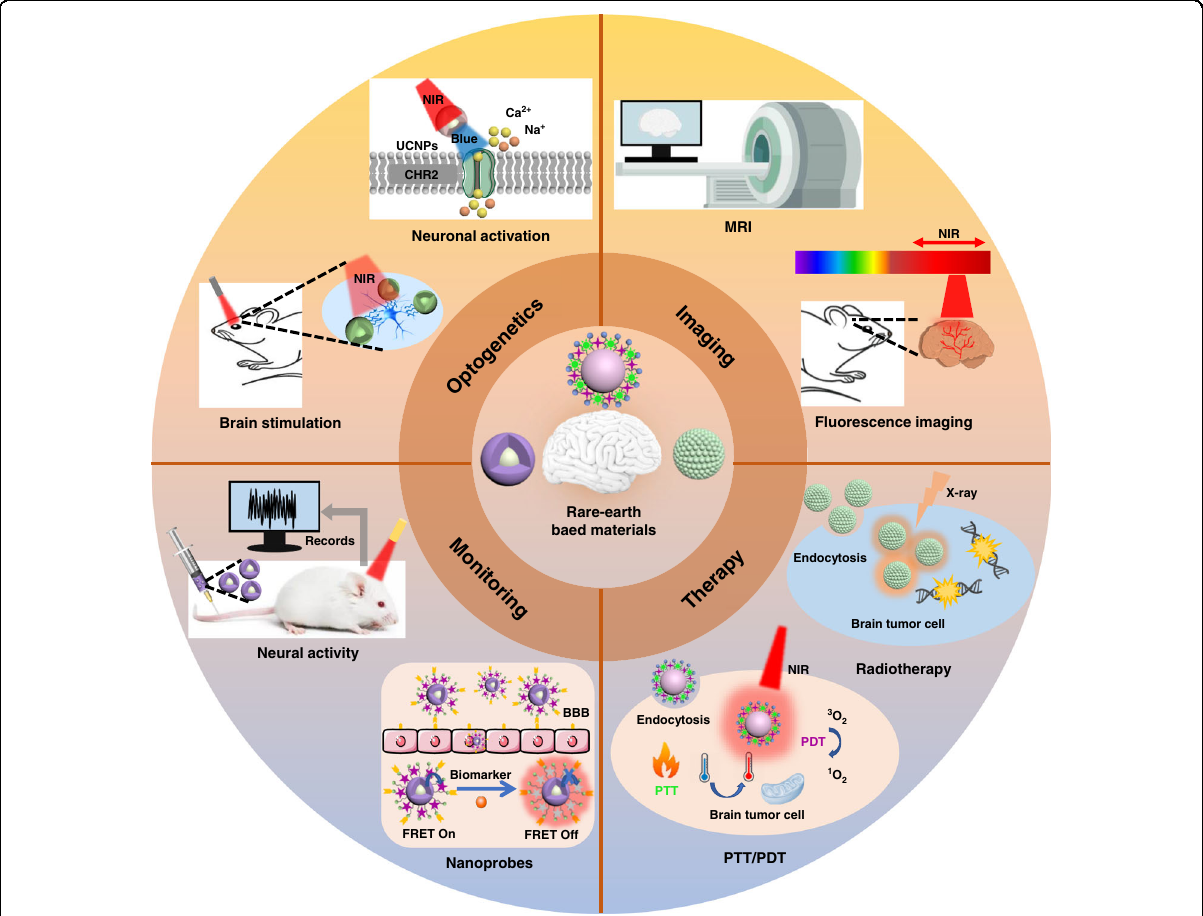
Fig. 1 The overview of applications of rare-earth based materials for brain disease diagnosis and